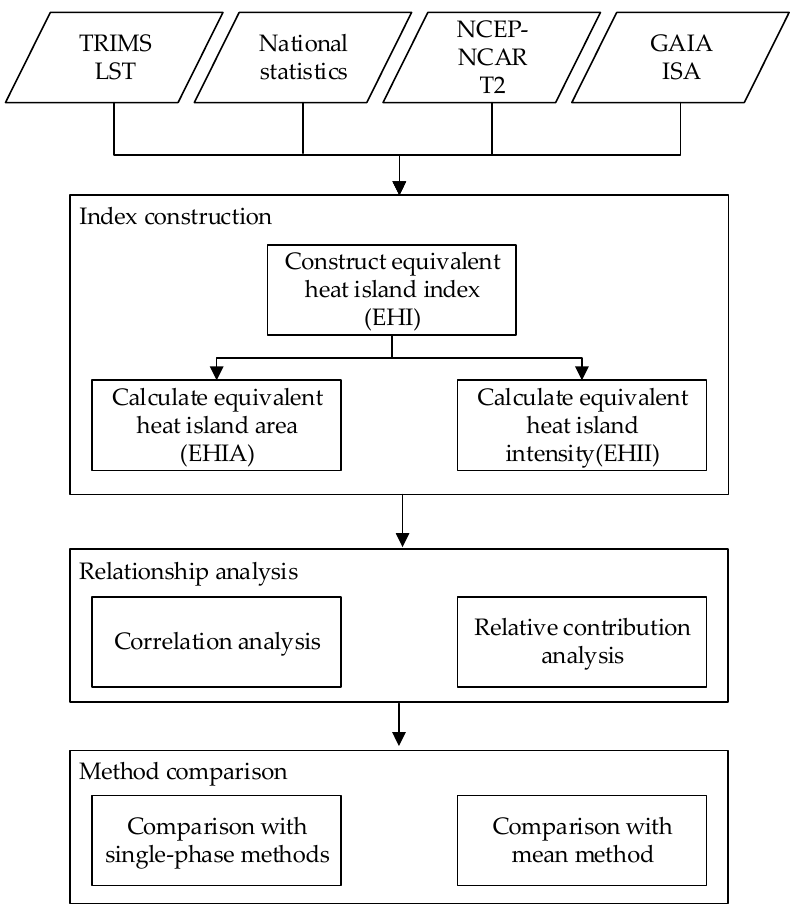
Figure 2. Research process.